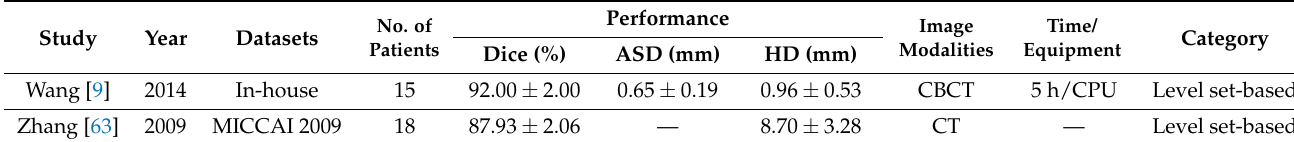
Table 5. Summary of level set-based